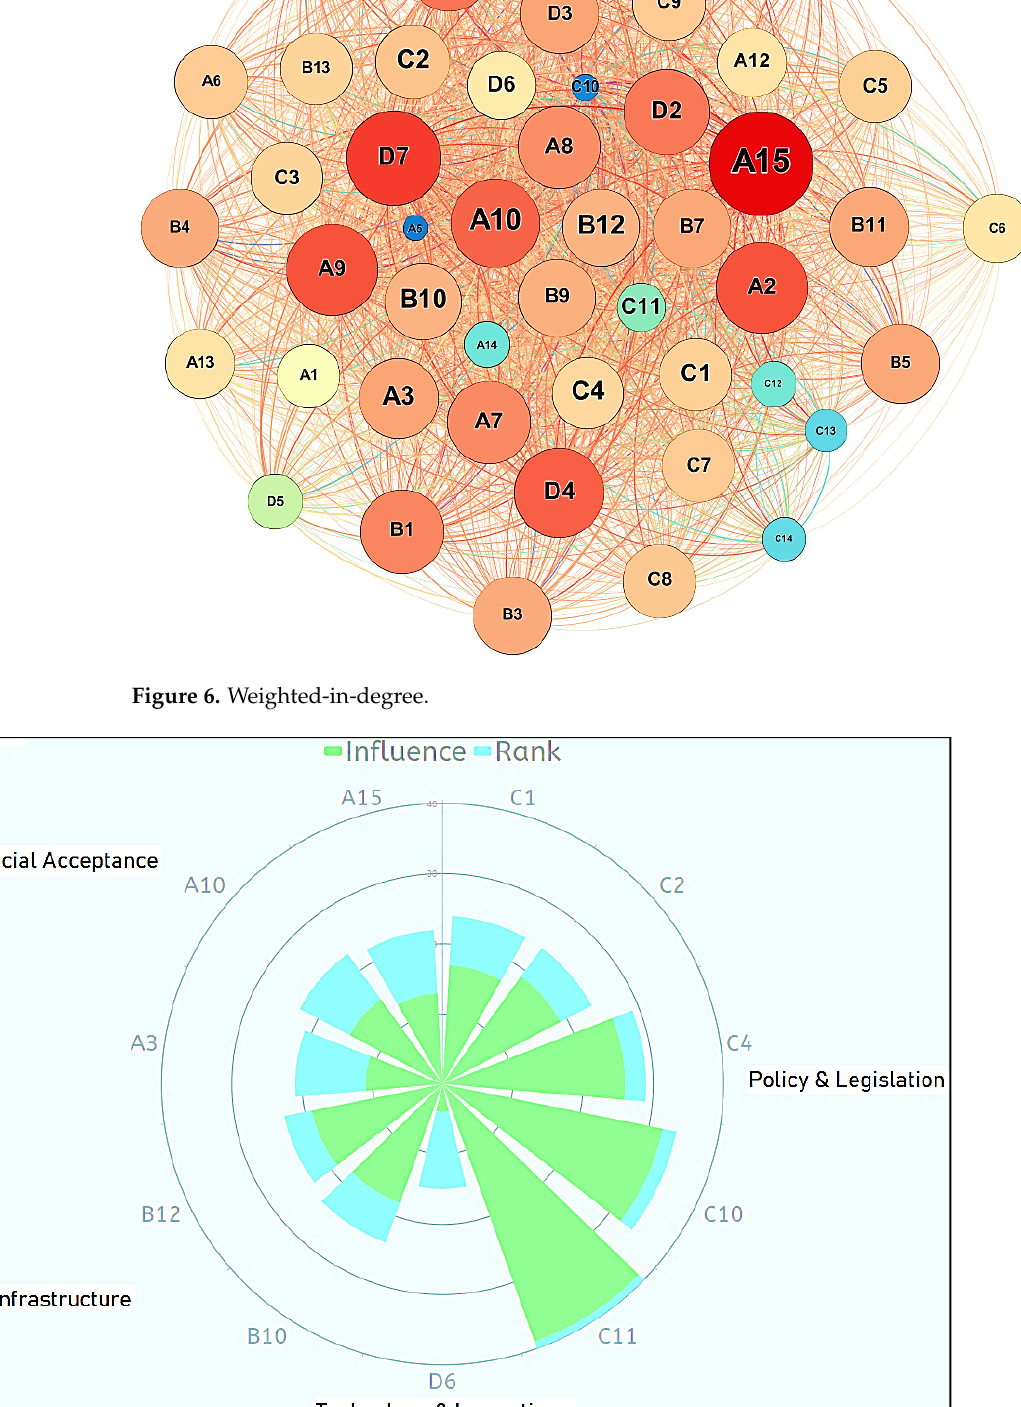
Figure 7. Influence and rank of the key AV adoption factors.